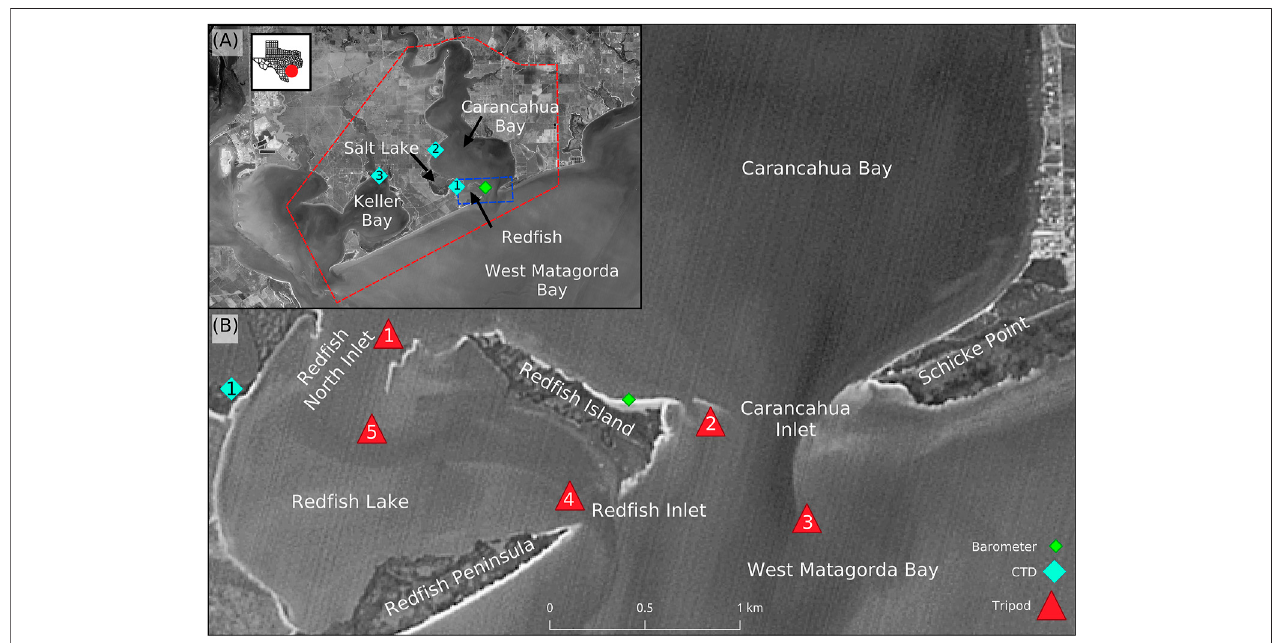
FIGURE 1 | Study area map. (A) indicates the study area outlined in red with the blue box indicating the extent shown in (B) .